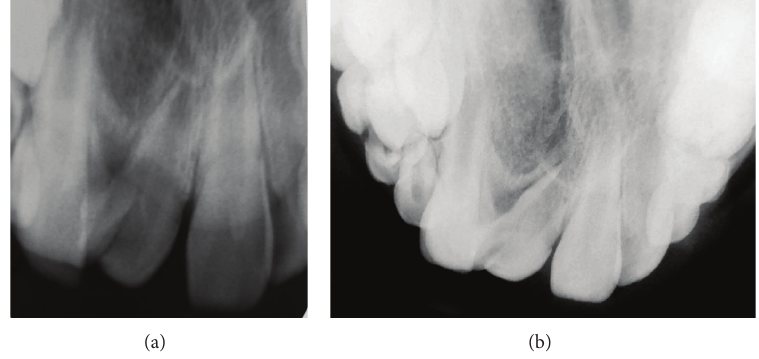
Figure 2: Radiographic appearance of fused tooth.